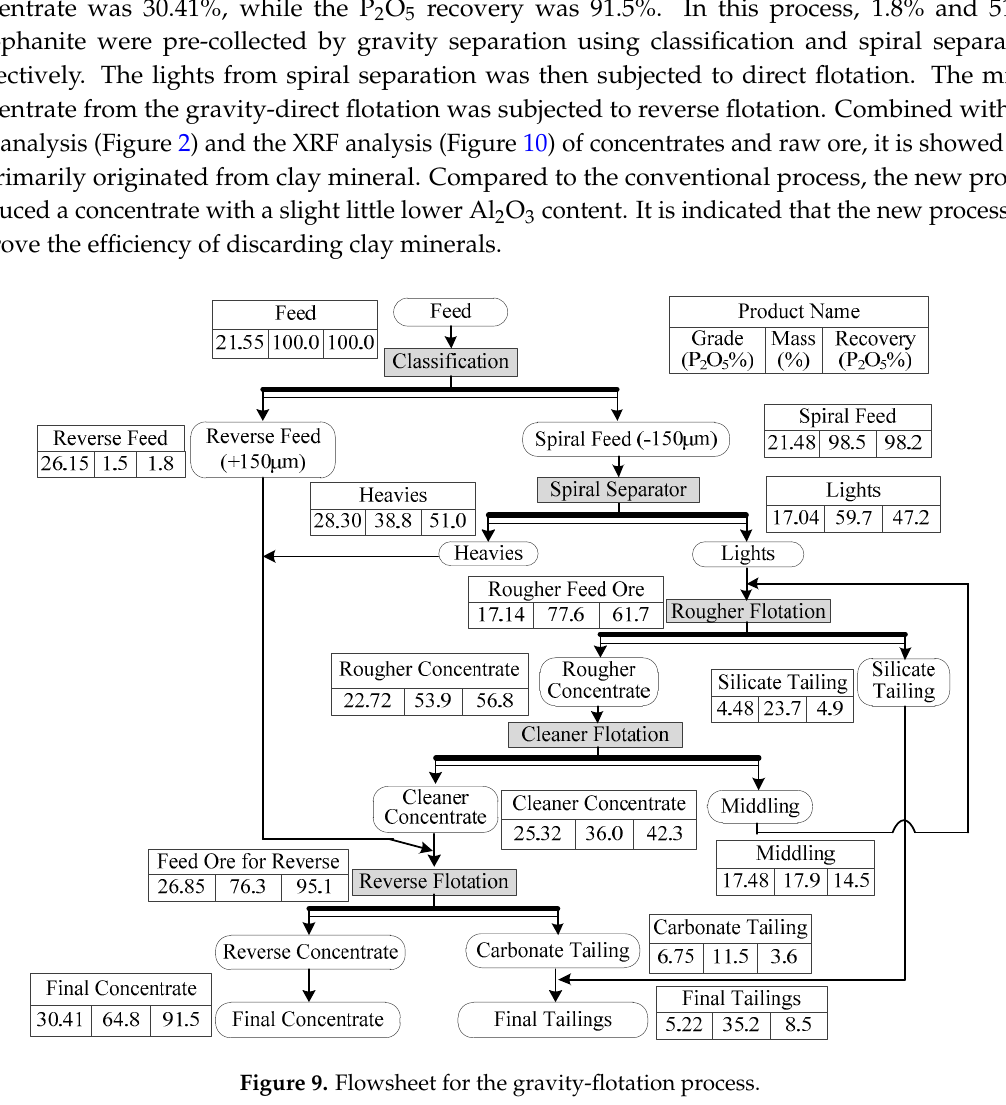
Figure 9. Flowsheet for the gravity-flotation process.